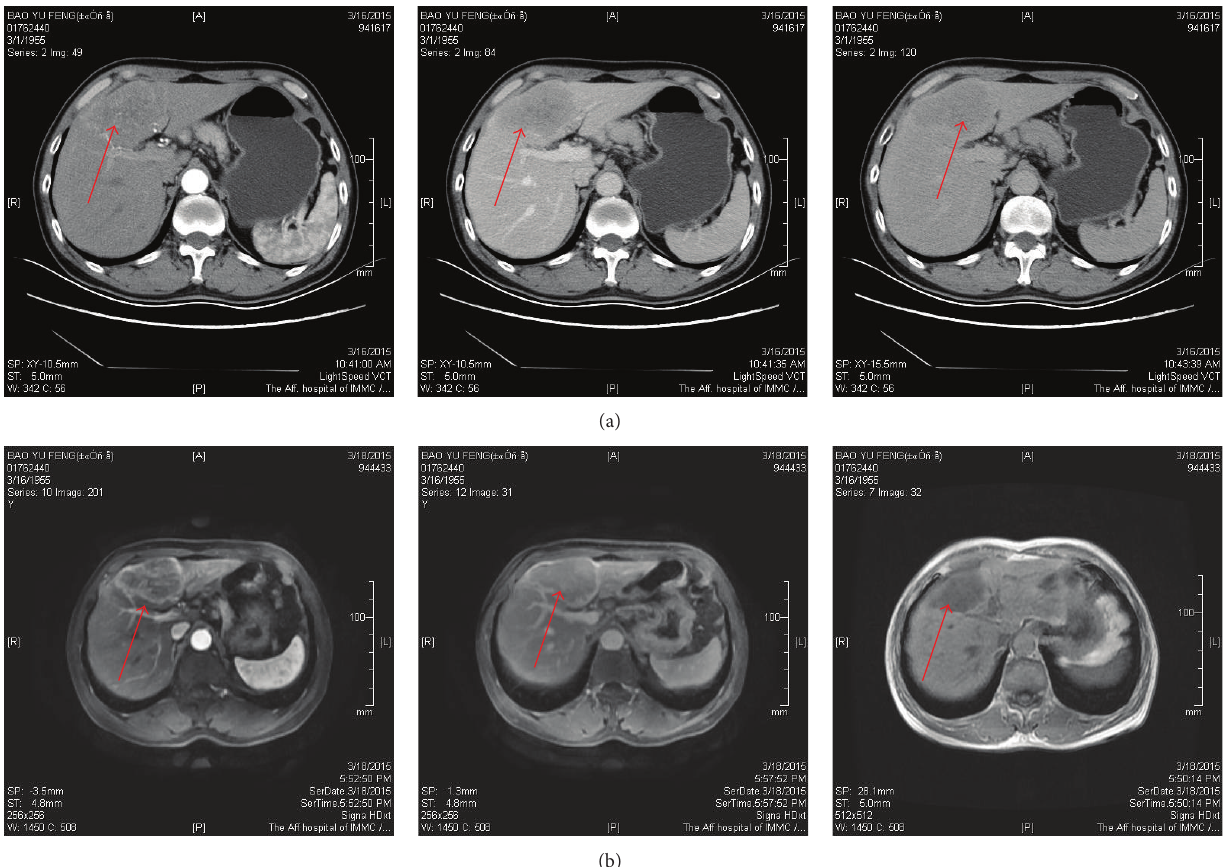
Figure 2: A 60-year-old man has a nodule of low density in the left hepatic lobe segment. (a) Multiphase CECT showed significant enhancement in arterial phase, the enhancement extent fade in portal and delay phase. (b) Multiphase contrast enhanced MRI showed typical enhancement pattern (red arrows in a, b). In conclusion, the lesion in the left hepatic lobe was consistent with